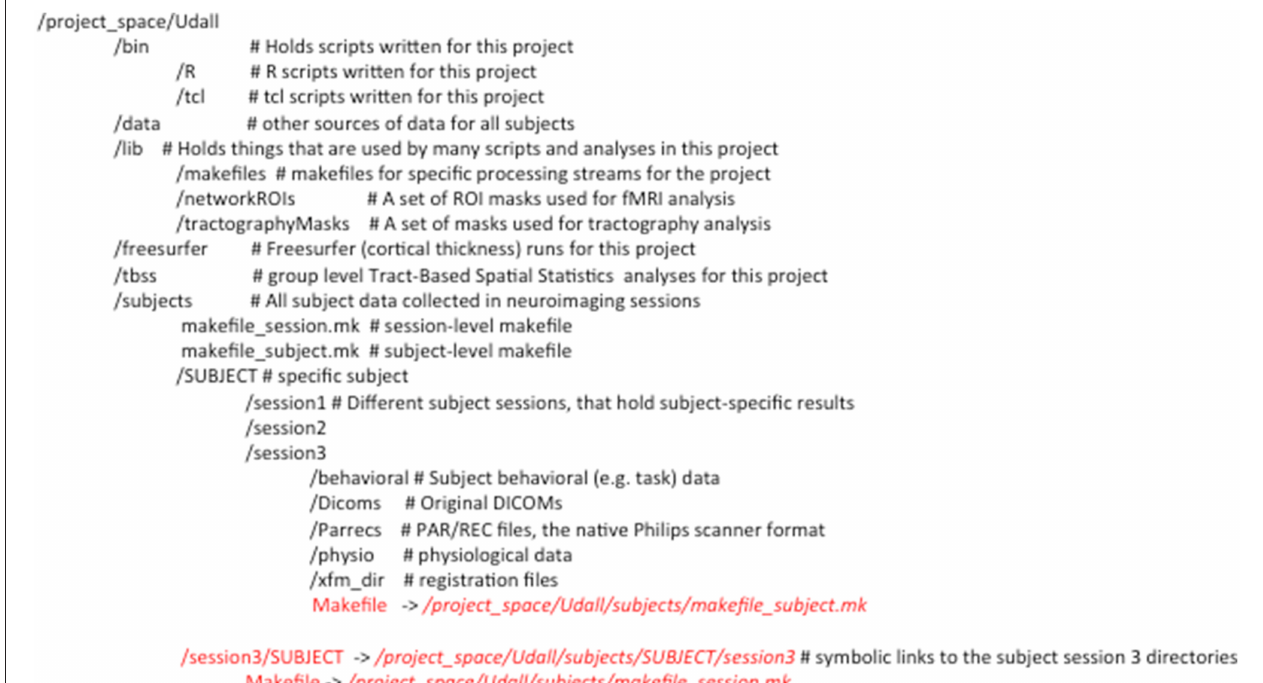
FIGURE 3 | Example directory structure for use with Make. Symbolic links are typeset in red with arrows to the files they point